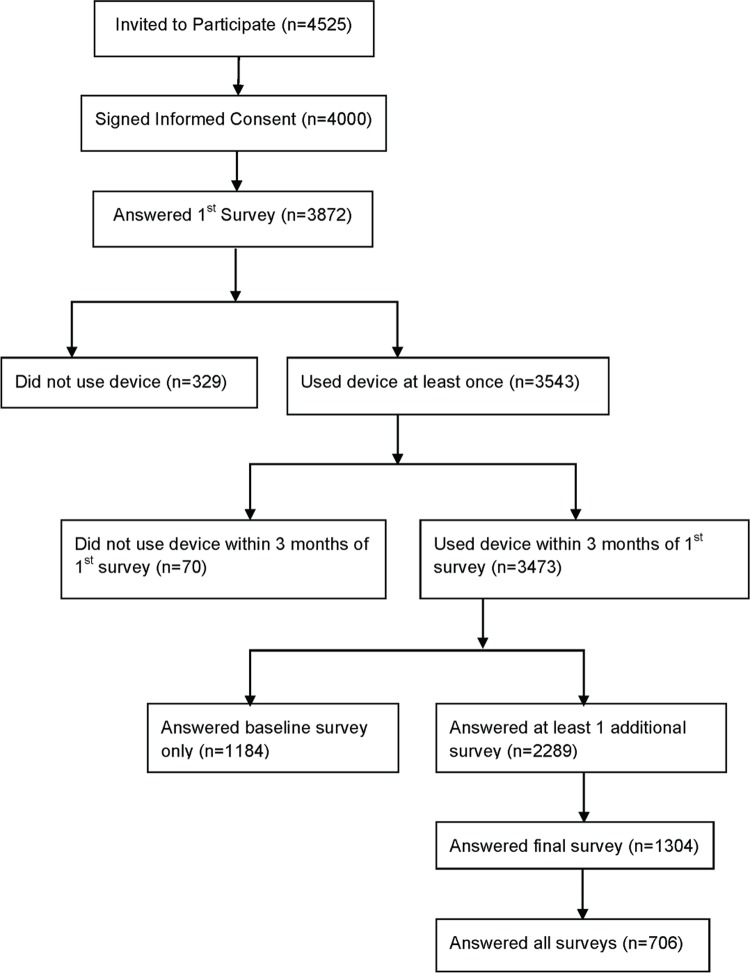
Participant flow chart.